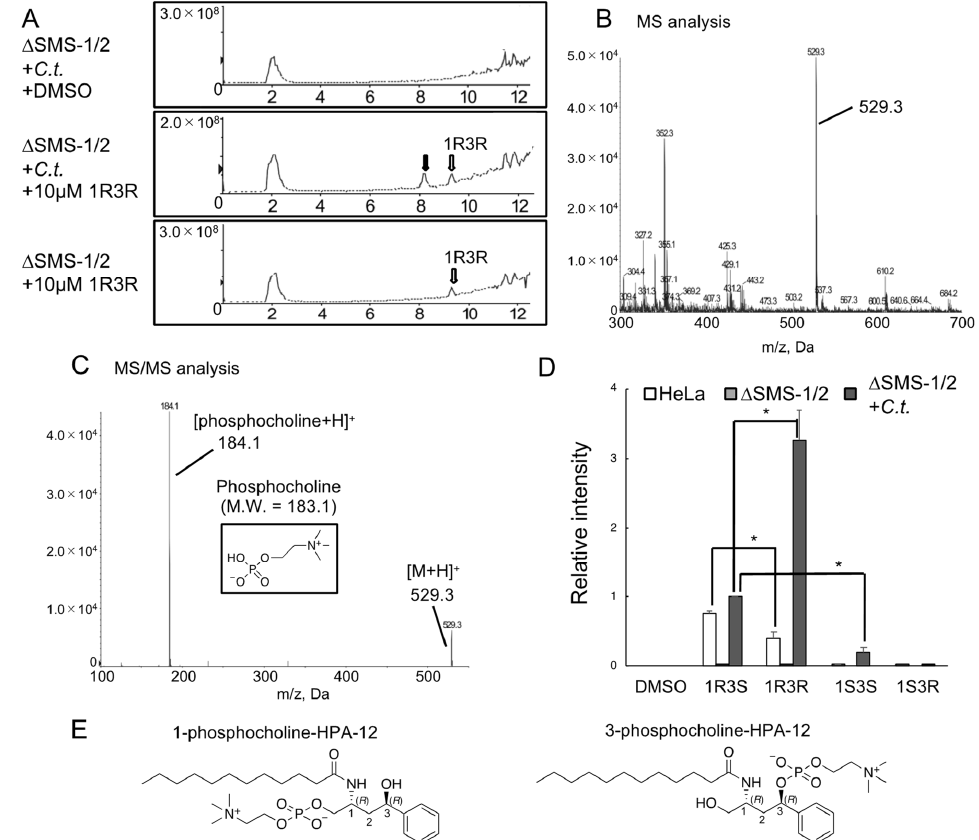
Figure 7. Phosphocholine-conjugated (1 R ,3 R )-HPA-12 produced by cidSM-synthesis. ( A ) Total ion chromatograms from single mass spectrometry (in the range of m / z = 300–700) of the methanol extracts from cells treated with 10 µ M of each compound. White arrows denote peaks that appeared dependent on the (1 R ,3 R )-HPA-12 addition; the black arrow indicates a peak that appeared dependent on both chlamydial infection and the (1 R ,3 R )-HPA-12 addition. ( B ) Mass spectra around the black arrow (retention time of 7–9 min) in Figure 7A of the chlamydia-infected HeLa ∆ SMS-1/2 cells. A signal close to the mass of phosphocholine-conjugated HPA-12 (PC-HPA-12, 529.3) was observed. ( C ) LC-MS/MS spectra of the precursor ion m / z 529.3. A signal corresponding to the mass of protonated cholinephosphate was observed. ( D ) The ratios of PC-HPA-12/d7-cholesterol in the indicated cells treated with the stereoisomers of HPA-12. The cells were treated with 3 µ M of each compound and the extracted lipids were analyzed by LC-MS/MS in the MRM mode. The data are shown as the mean ± SD from three independent experiments and a two-tailed paired Student’s t -test with a Bonferroni correction was performed (* p < 0.0167). ( E ) The supposed chemical structures of PC-HPA-12. The systematic chemical name of the compound HPA-12 is N -(3-hydroxy- 1-hydroxymethyl-3-phenylpropyl)dodecanamide (16). Thus, 1-phosphocholine-HPA-12 means a derivative of HPA-12 with a phosphocholine adduct at the 1-hydroxymethyl